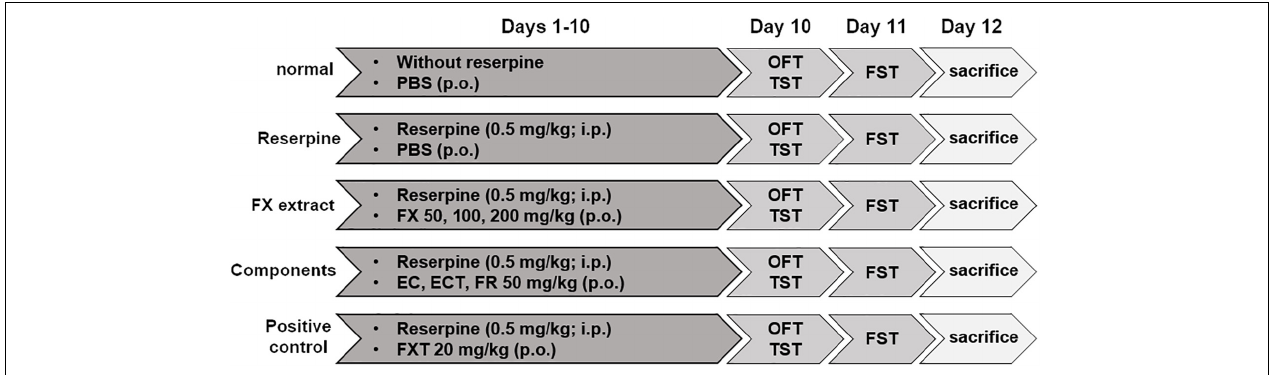
FIGURE 1 | Schematic diagram showing the experimental design. Drugs were orally and intraperitoneally administered from days 1 to 10. The OFT, TST, and pre-FST were performed on day 10. The FST was conducted on day 11. All mice were sacrificed on day 12.